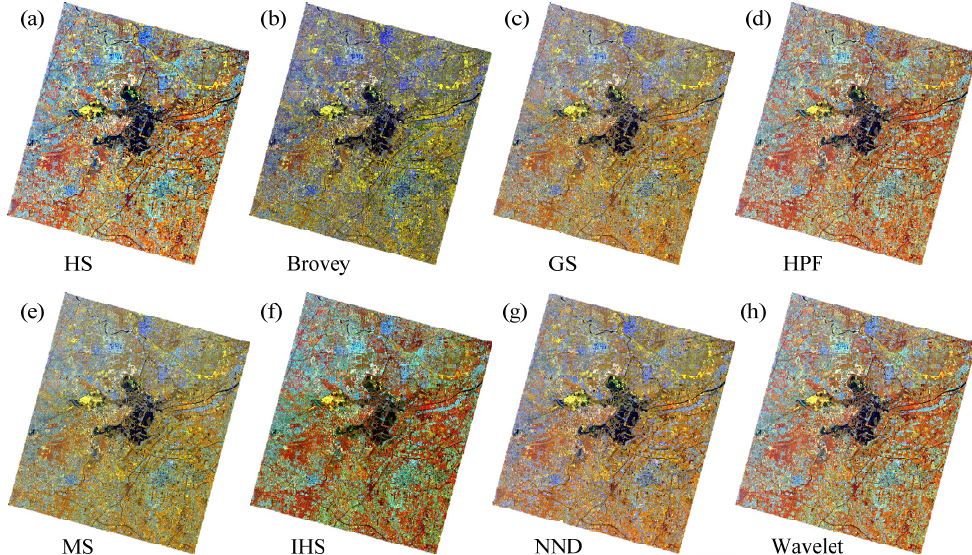
Figure 5. Experimental results of ZY-1 02D hyperspectral and multispectral data fusion. ( a ) ZY-1 02D hyperspectral image; ( b ) Brovey image; ( c ) GS image; ( d ) HPF image; ( e ) ZY-1 02D multispectral image; ( f ) IHS image; ( g ) NND image; ( h ) Wavelet image.